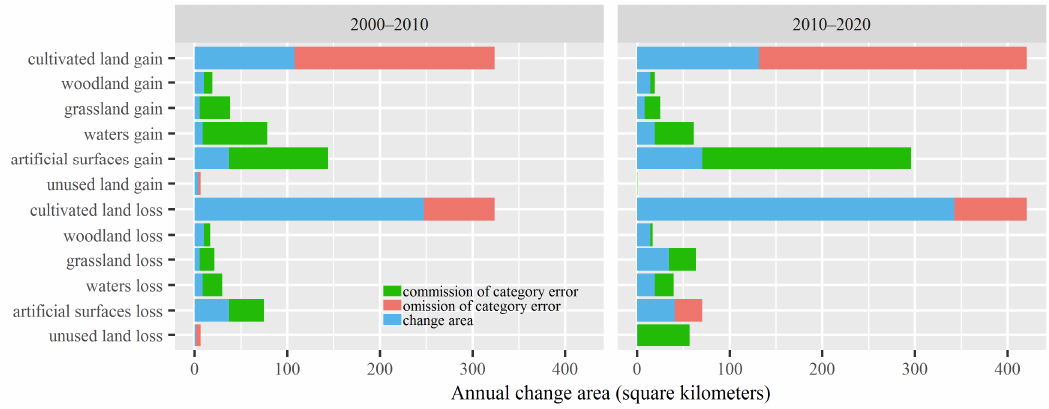
Figure 9. Category level change sizes along with hypothetical errors for the lower reaches of the YRB.